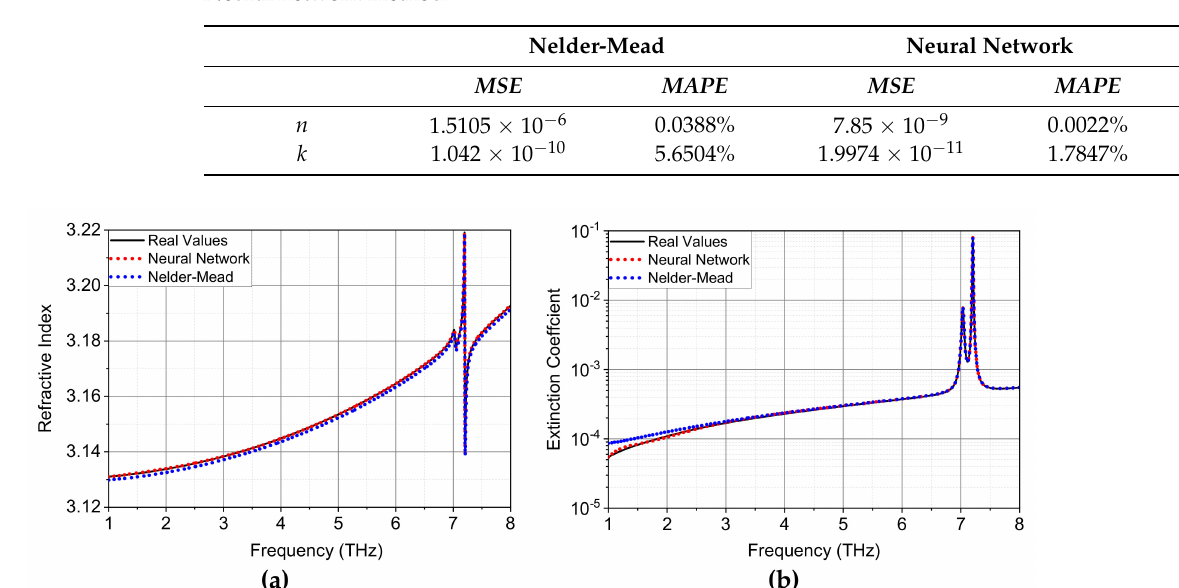
Table 4. Statistical error of the prediction values of 6H SiC with the Nelder-Mead algorithm and Neural network method.